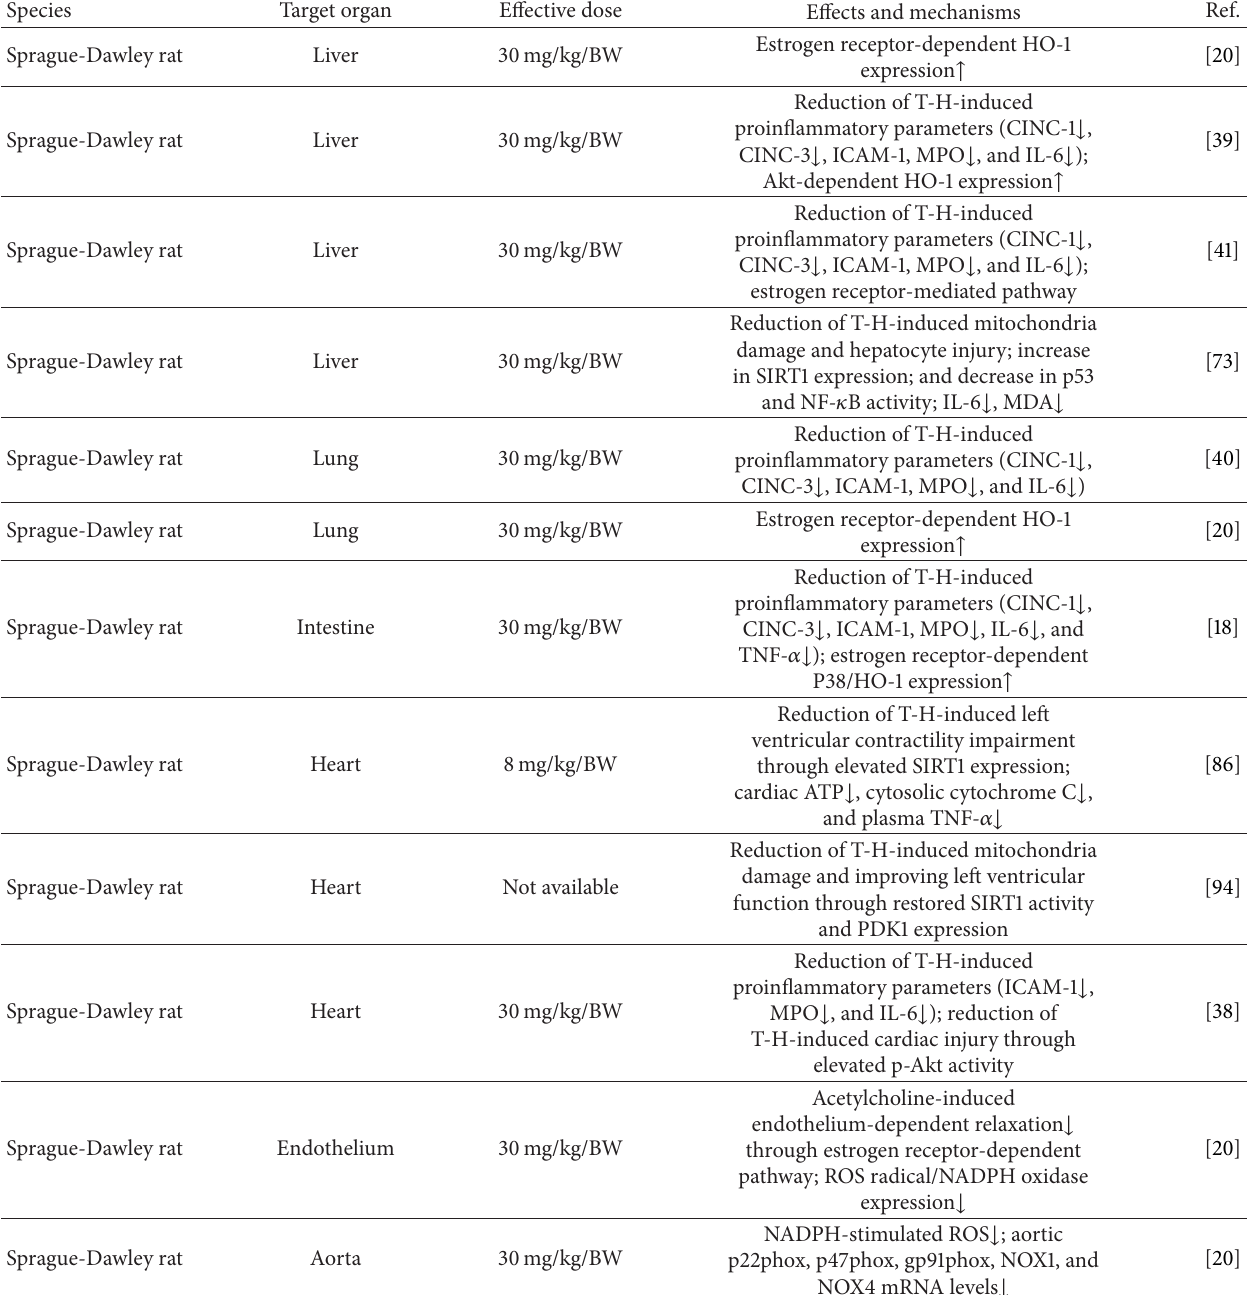
Table 1: The organ-protective effects and mechanisms of resveratrol in trauma-hemorrhagic injury. Species